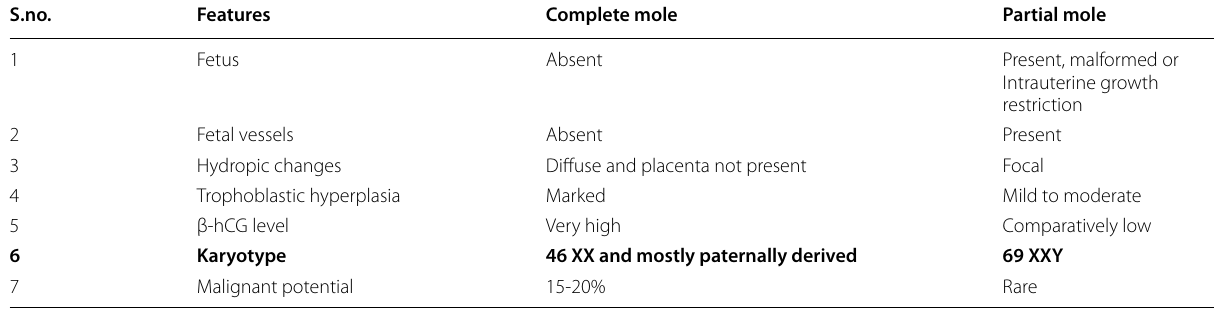
Table 1 Important features of complete and partial hydatidiform mole S.no.